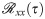
Top panels: Lagrangian autocorrelation functions Rxx(τ) and Ryy(τ). Bottom panel: Lagrangian time scales TLx, TLy and their average TL.